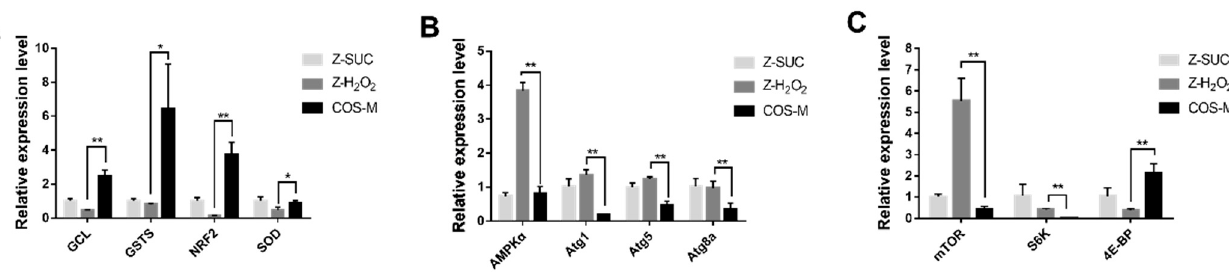
Figure 9. Carrageenan oligosaccharides alter the gut microbiota and the relevant pathways of H 2 O 2 -induced female Drosophila . ( A ) The cladogram of the gut microbiota community of female Drosophila in Z-H 2 O 2 , Z-SUC and COS-M groups. ( B ) Prediction of the relative abundance of stress-tolerant bacteria of the gut microbiota of female Drosophila in Z-H 2 O 2 , Z-SUC and COS-M groups using BugBase. ( C ) KEGG pathways predicted using PICRUSt 2, and the t-test was used to perform a significance analysis.